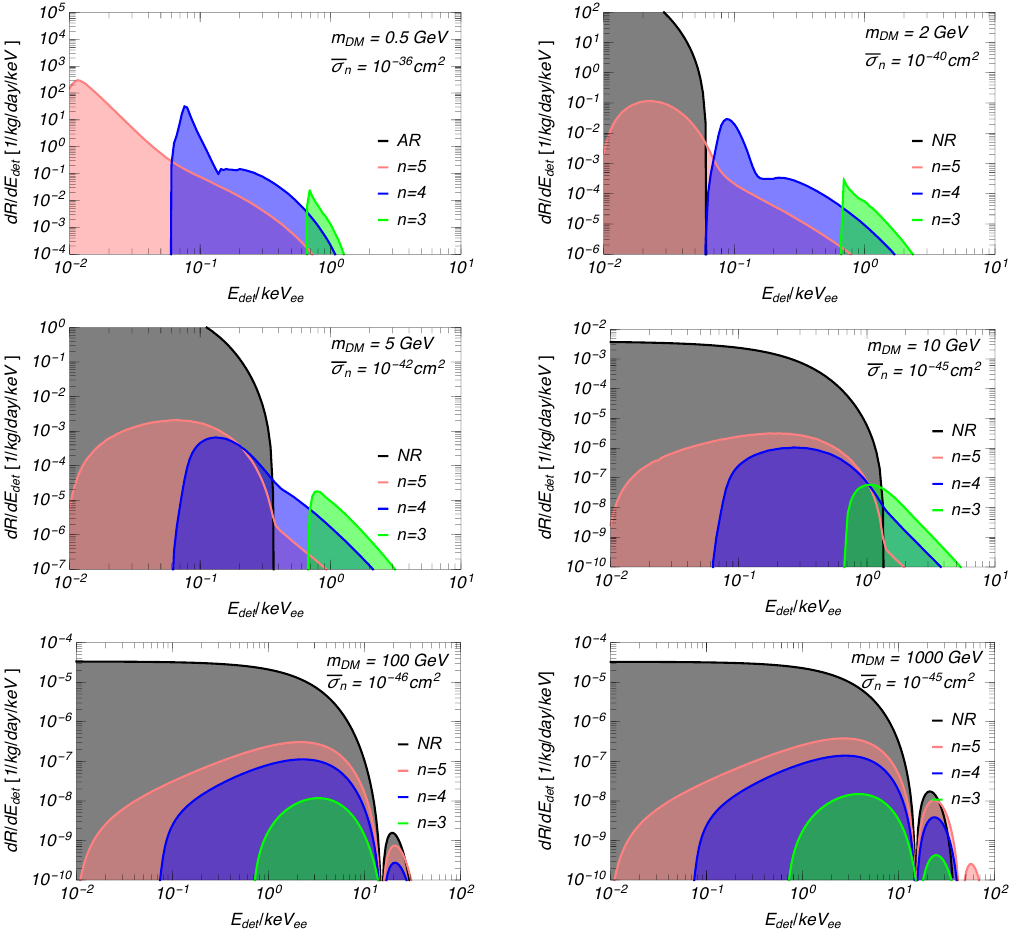
Figure 5 . The di(cid:11)erential event rates expected at the single-phase experiments with the liquid Xe target. The black lines show the nuclear recoil (NR) spectrum without ionization. (The NR spectrum with respect to E det and the one with respect to E R di(cid:11)er by a factor of 1 =q nr .) The green, blue, and pink lines show the ionization rates from n = 3 ; 4, and 5, respectively. Here, we do not take the energy resolution into account. Since we apply the estimations for the isolated atoms, the ionization spectrum from the valence electrons, i.e. n = 5, are not